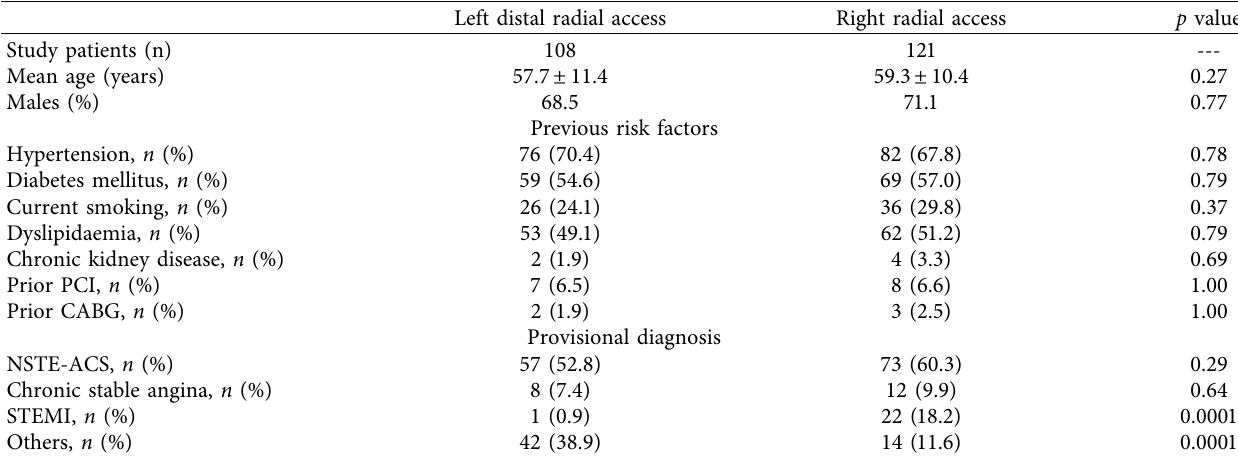
Figure 4: Flowchart depicting patient distribution in the study. Table 1: Baseline characteristics of